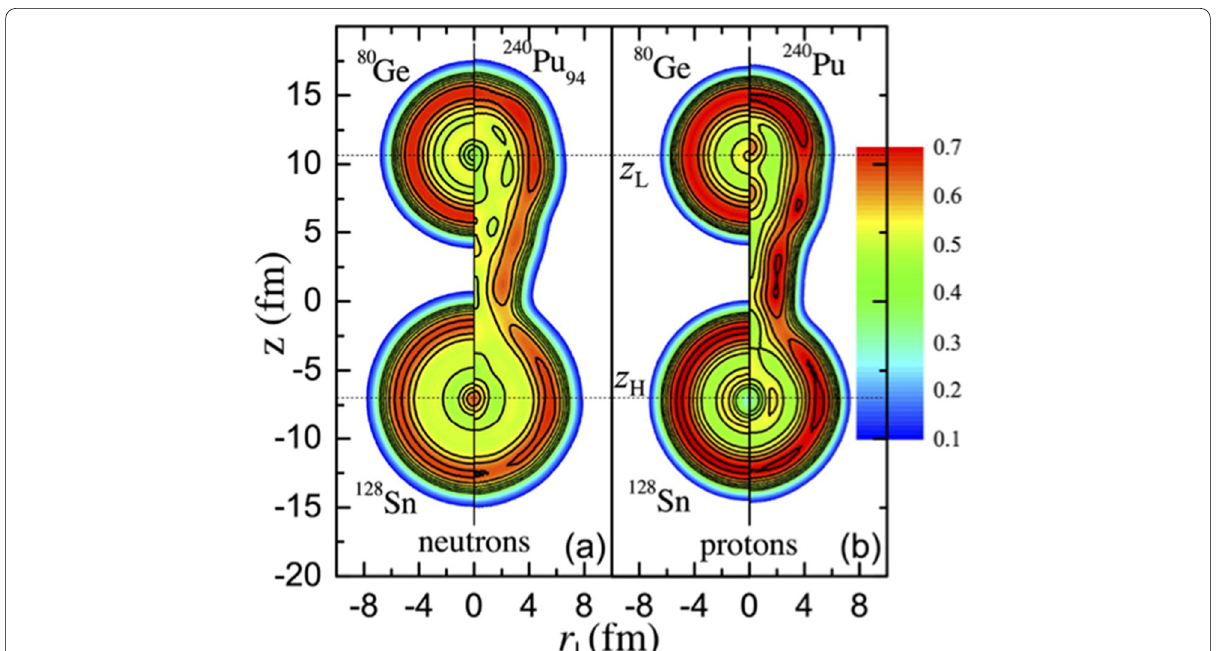
Fig. 16 Neutron ( a ) and proton ( b ) NLFs in a deformed configuration on the fission path of 240 Pu (right panels). NLFs of the localized prefragments, 80 Ge and 128 Sn, are compared (left panels). Vertical lines are symmetry axes. Maximum extensions of the NLFs along the radial coordinate r marked with horizontal dotted lines: z z L and z z H . The figure is adapted from [121] = =